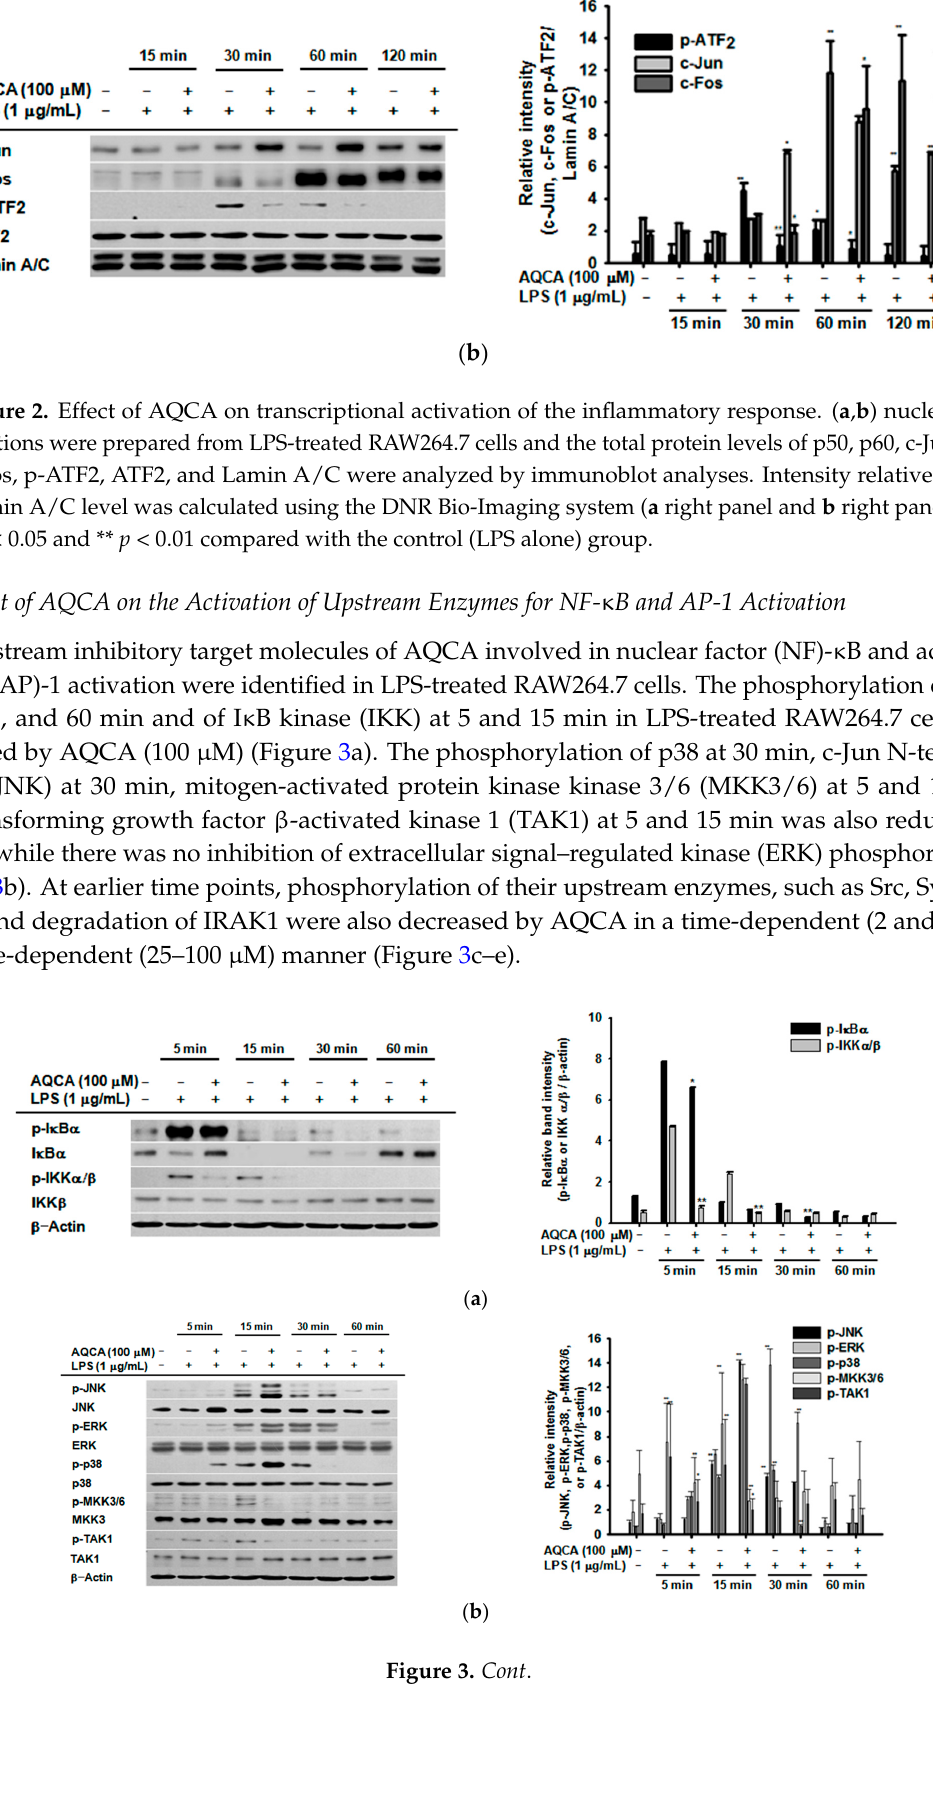
Figure 2. Effect of AQCA on transcriptional activation of the inflammatory response. ( a , b ) nuclear